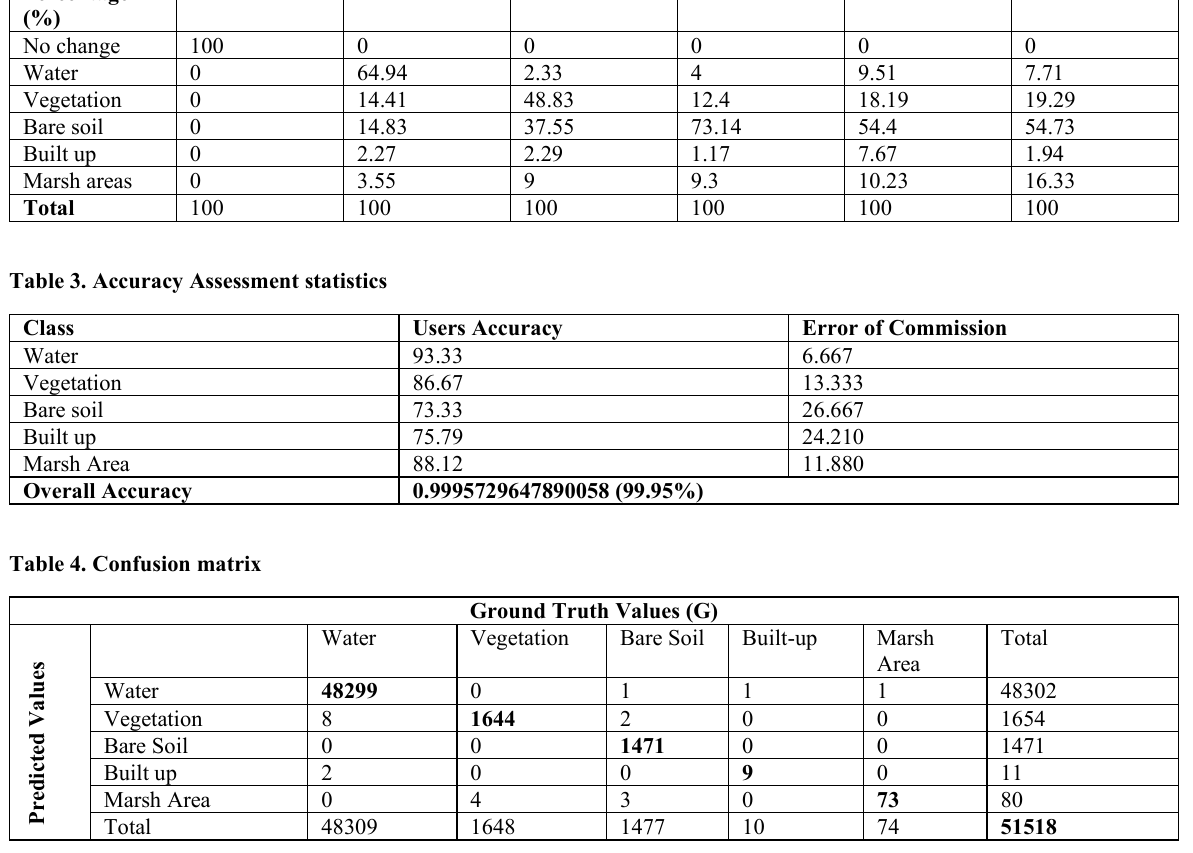
Figure 5 (b) Spatio-Temporal Land Cover Classes Variation for after the Hurricane Ida Impact (2021). Table 2. Over-all land cover change statistics for before and after the Hurricane Ida Landfall. Area Covered